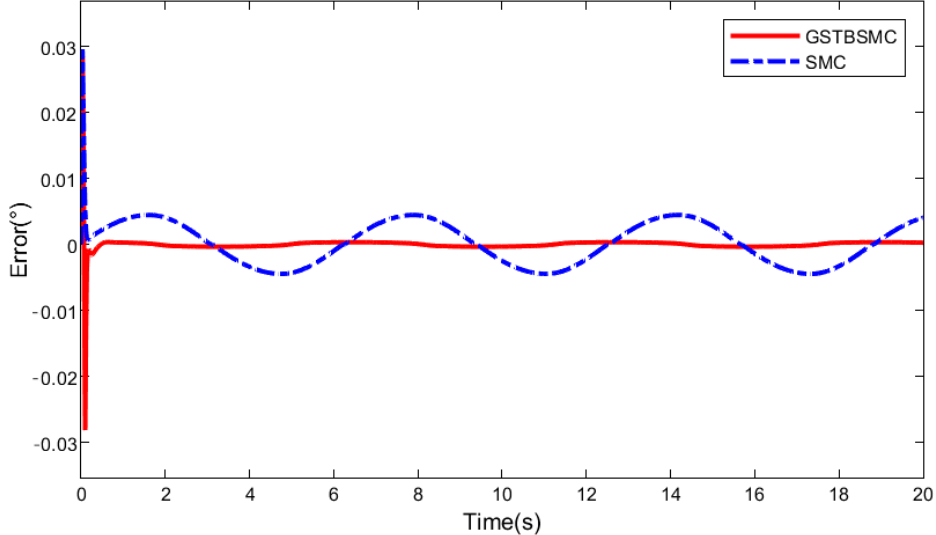
Figure 9. Tracking error comparison between GSTBSMC and SMC in Experiment 1.